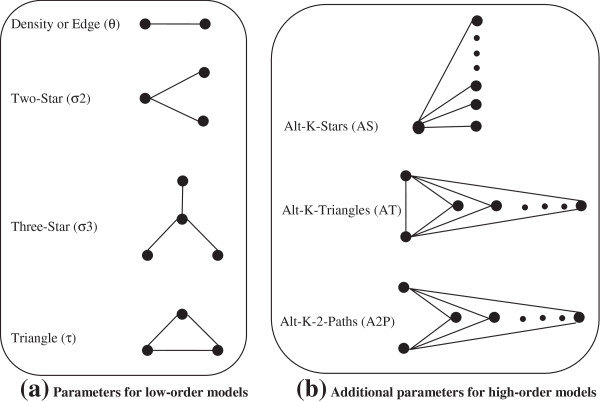
Configurations and parameters for exponential random graph models [[50]].